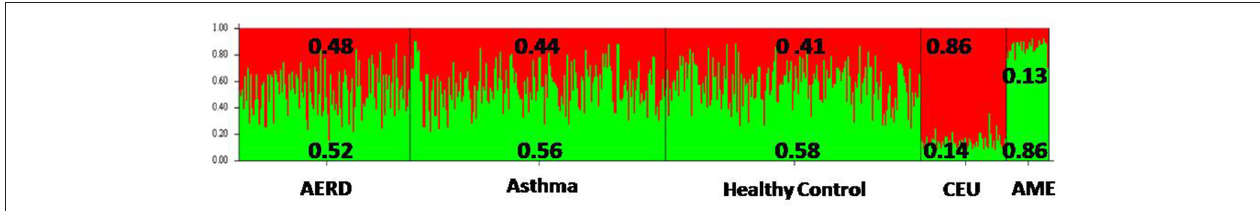
FIGURE 3 | Frequency of ancestry of the three groups of study, according to the two principal ancestral groups that integrate Mexican Mestizo population. AERD, Aspirin-Exacerbated Respiratory Disease; CEU, Caucasian European; AME, Amerindian.